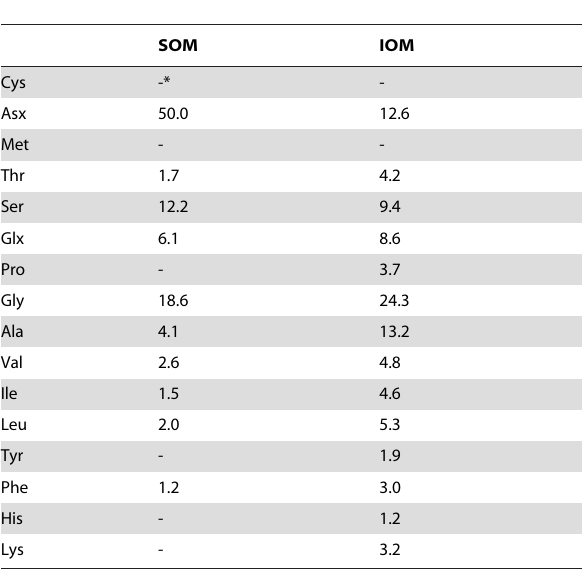
*- indicates a not detectable amount.